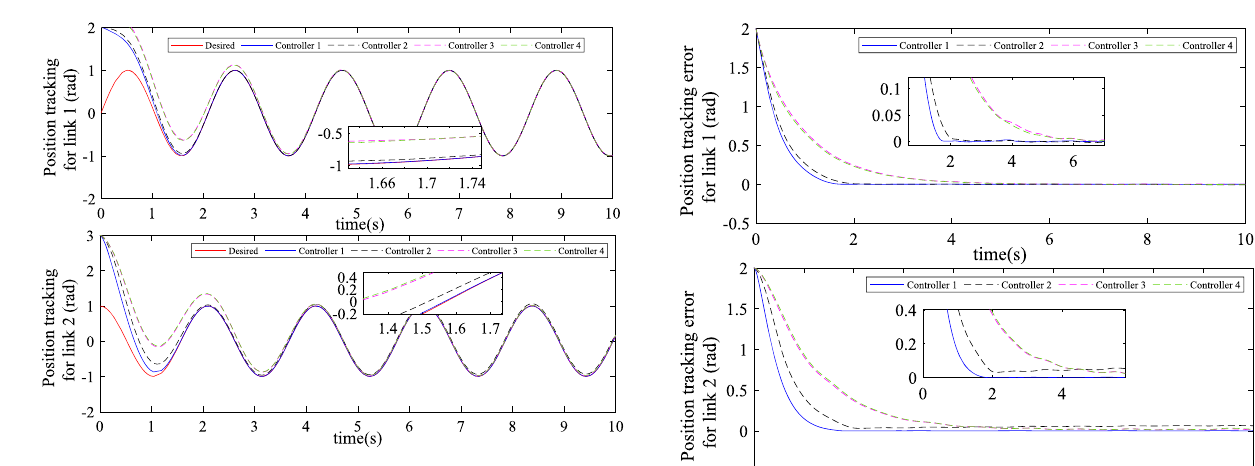
Fig. 1 Trajectory tracking curve